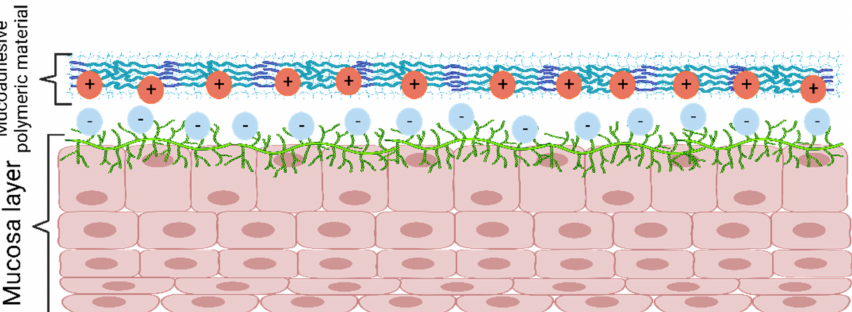
Figure 7. Mucoadhesion mechanism according to electronic theory. Created with BioRender.com